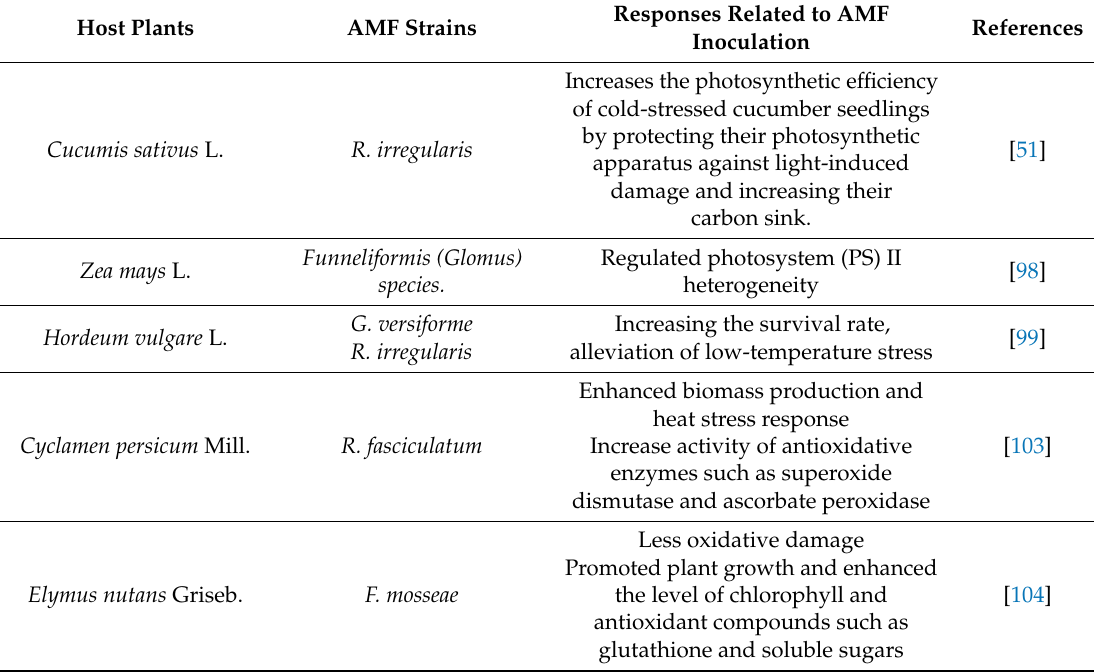
Table 3. Contribution of AMF in helping plants to cope with extreme temperatures